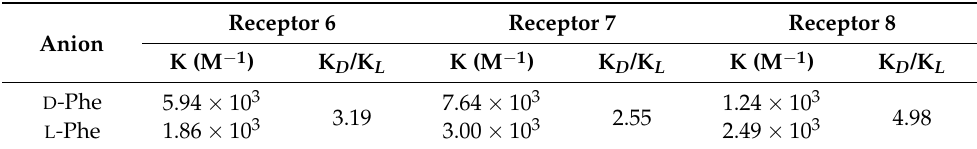
Table 1. Association constants and chiral recognition K D /K L for receptors 6 , 7 , and 8 with TBA salts of D - and L -Phe, respectively, in DMSO.